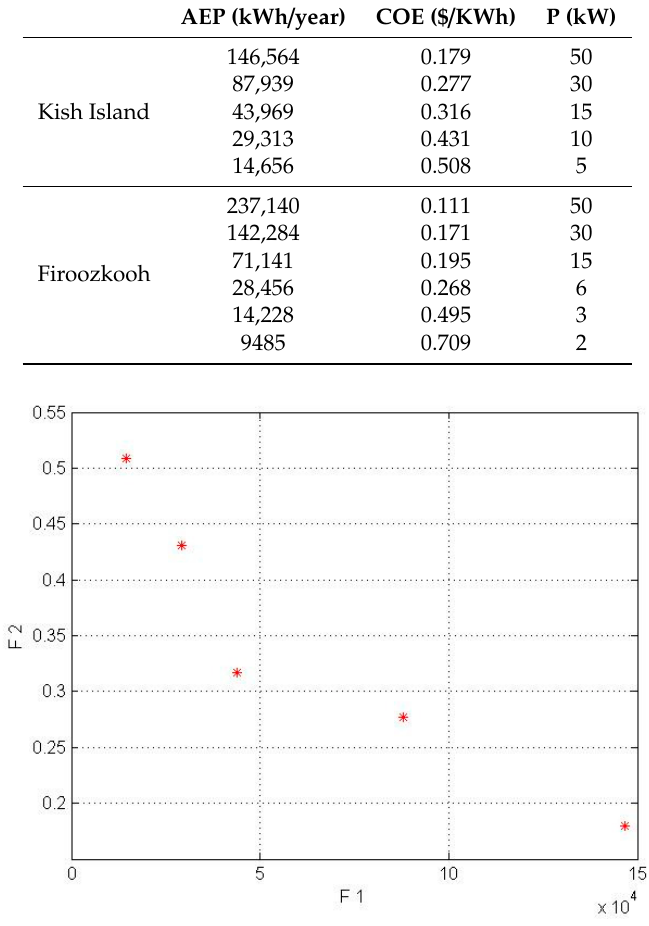
Figure 5. Pareto front for Kish Island in the wind lens turbine model (* shows COE by AEP).